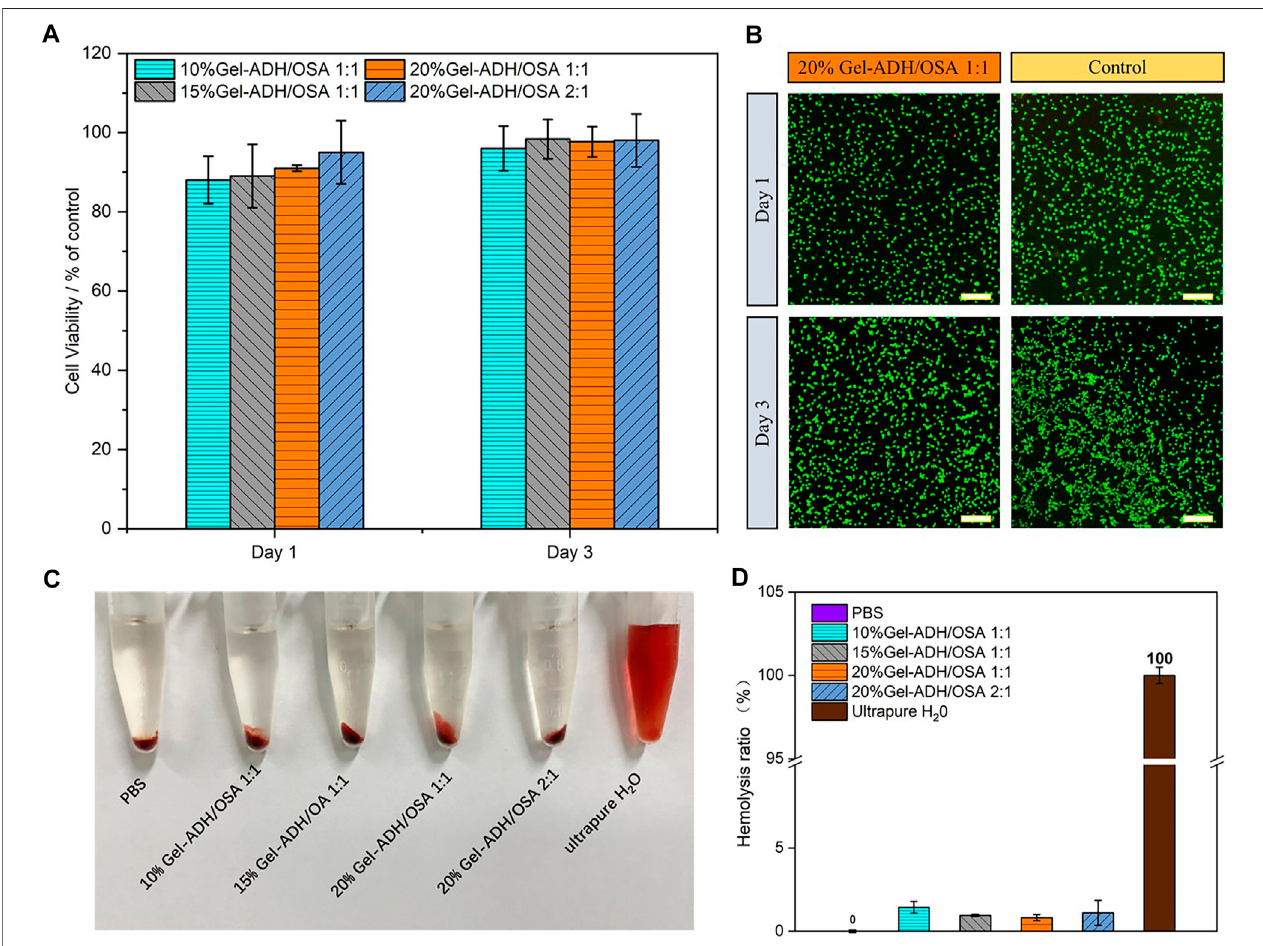
FIGURE4|(A) CellviabilityassayofL929cellsafterbeingincubatedwithGel-ADH / OSAhydrogelswithdifferentcomponentsandconcentrationsfor1and3days (B) Live / deadstainingofL929cellsafterbeingincubatedwiththe20%Gel-ADH / OSA1:1hydrogelfor1and3days(scalebar (cid:1) 100 μ m). (C) Imageand (D) quantitative analysis of the hemolytic activity of Gel-ADH/OSA hydrogels with different components and concentrations.